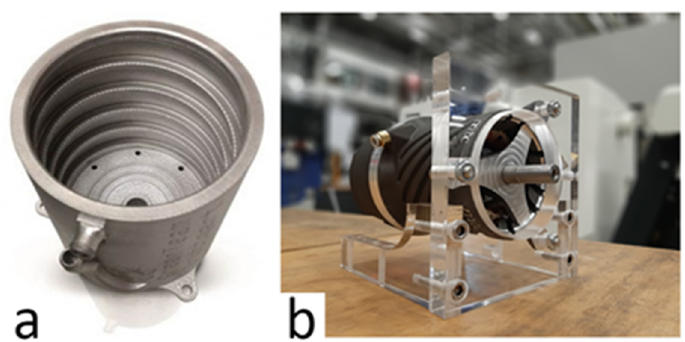
Figure 11. Additively manufactured cooling jackets ( a ) [74] and ( b )